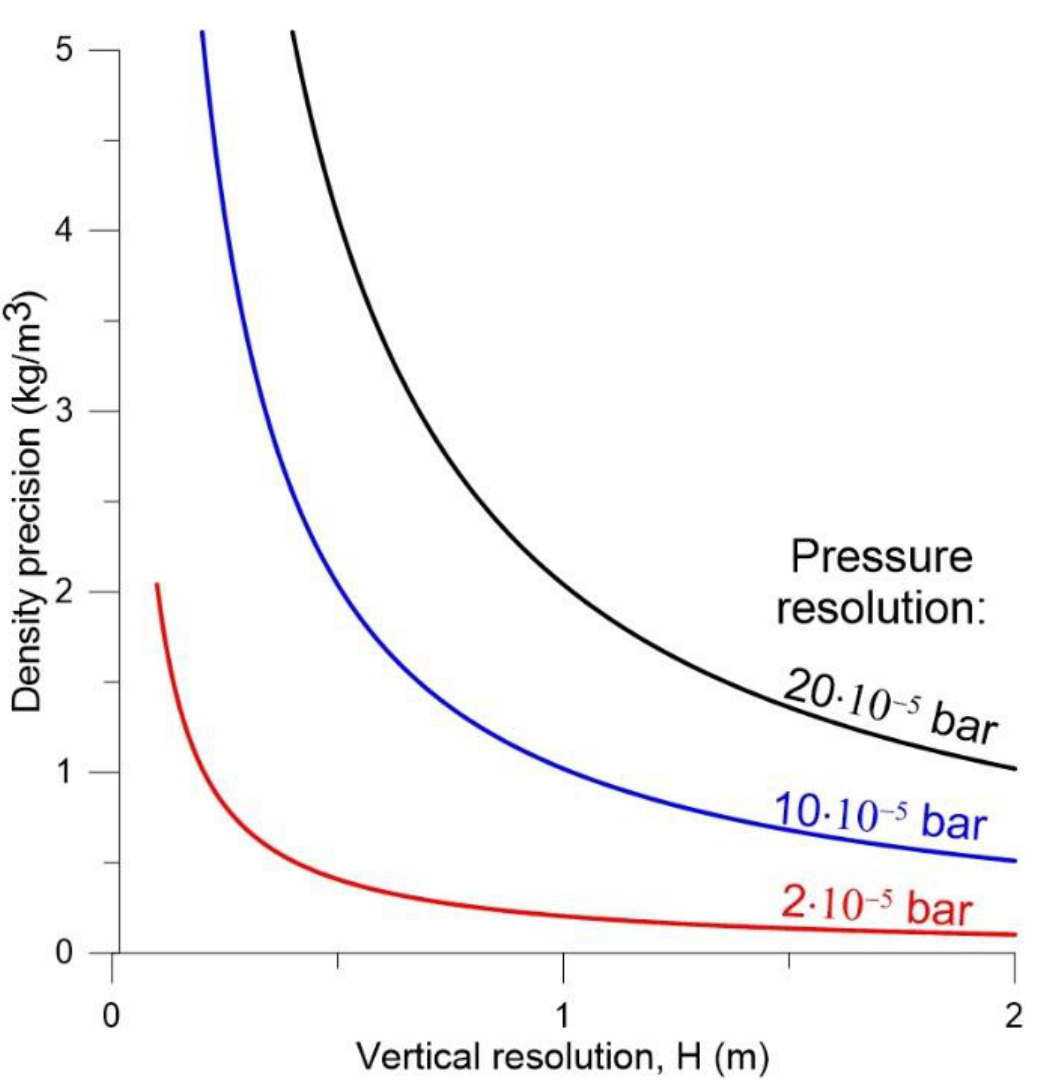
Figure 2. Resolution of the hydrostatic profiler based on Equation (8). The density precision and the vertical-distance resolution are anticorrelated, and the performance depends on the pressure sensor resolution. We present the solution of Equation (8) for three common pressure resolutions in typical pressure transducers. Using this diagram, one can examine the feasibility of using the hydrostatic densitometer for a specific system with a given density